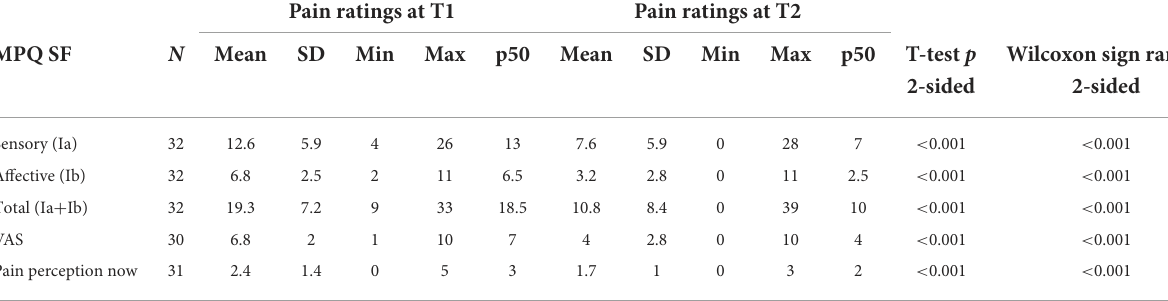
TABLE 2 Pain ratings at two timepoints measured by McGill Pain Questionnaire (German Short Form).